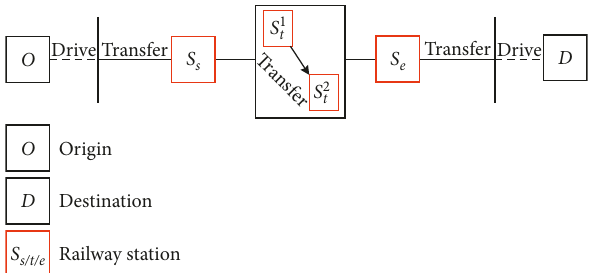
Figure 2: Passenger transfer cost